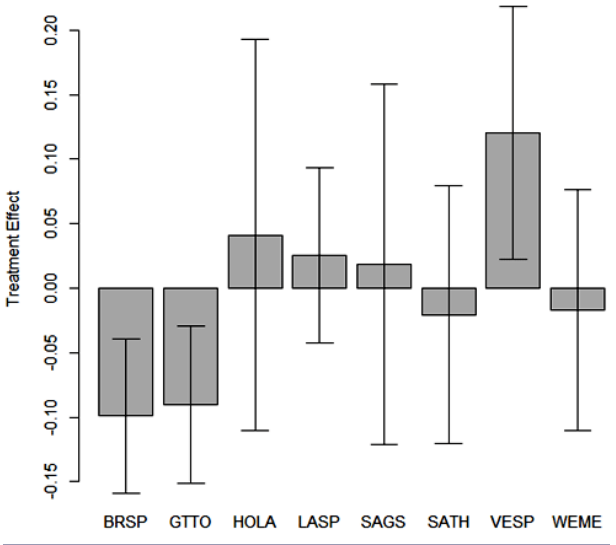
Fig. 3 . Estimated differences in occupancy of eight passerine birds on treated versus control sagebrush sites in western Colorado. Birds species are Brewer’s Sparrow ( Spizella breweri, BRSP), Green-tailed Towhee ( Pipilo chlorurus, GTTO), Horned Lark ( Eremophila alpestris , HOLA), Lark Sparrow ( Chondestes grammacus, LASP), Sage Sparrow ( Amphispiza belli,